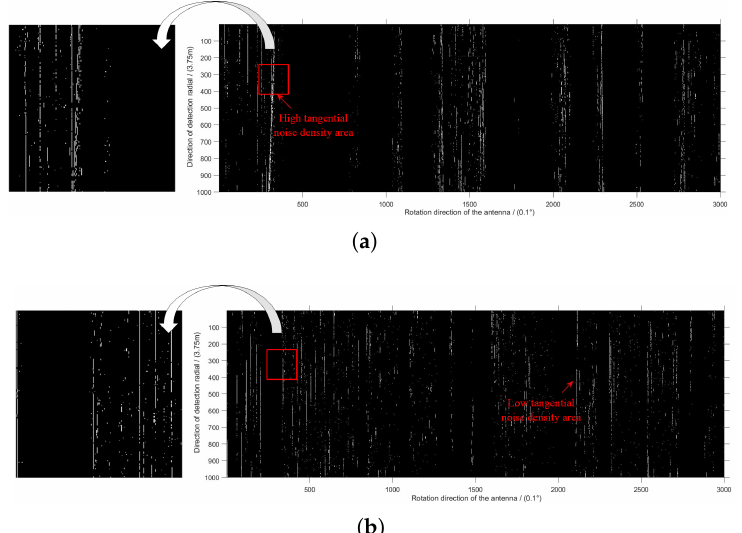
Figure 4. Comparison of high and low tangential interference ratio regions. ( a ) High tangential interference ratio regions, ( b ) low tangential interference ratio regions.